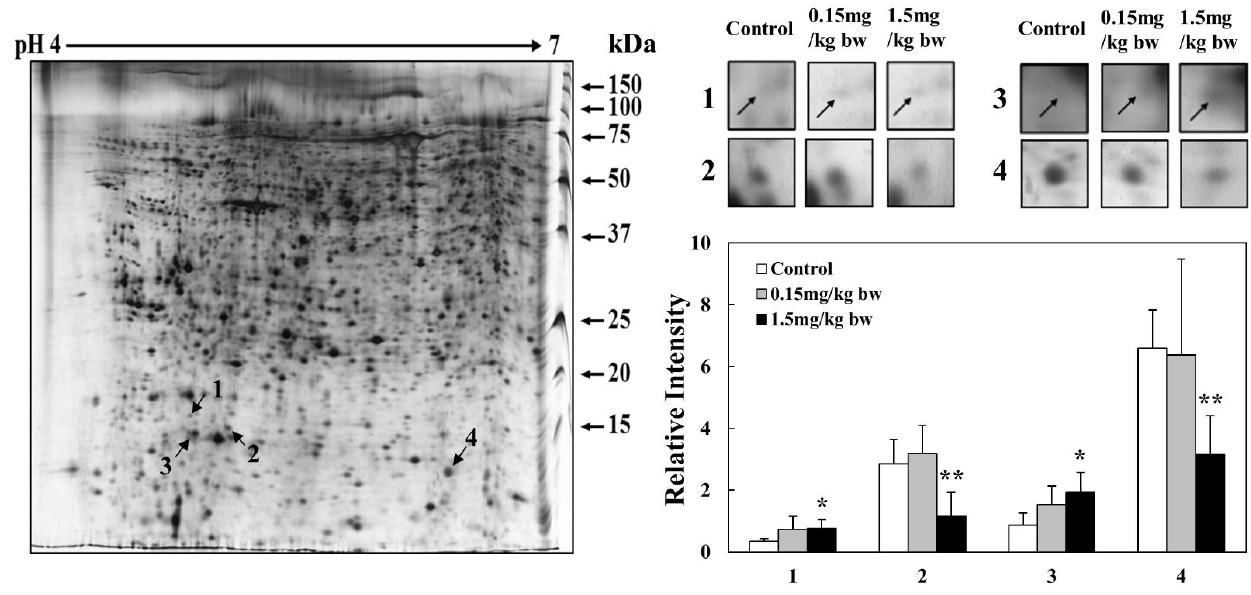
Figure 7. 2-DE analysis of lung tissue proteins obtained using 4 – 7 pI range strips. Gel patterns of tissue proteins obtained using 4 – 7 pI strips. Protein spot images were analyzed using the Progenesis Samespot software program (Nonlinear Dynamics, Newcastle upon Tyne, UK). Spot volumes were normalized by comparison with the total spot volume. The quantity of each spot is presented as the relative intensity. The images represent the means ± SD of five separate experiments; * and ** indicate p -values of 0.05 and 0.01, respectively, compared with the control.